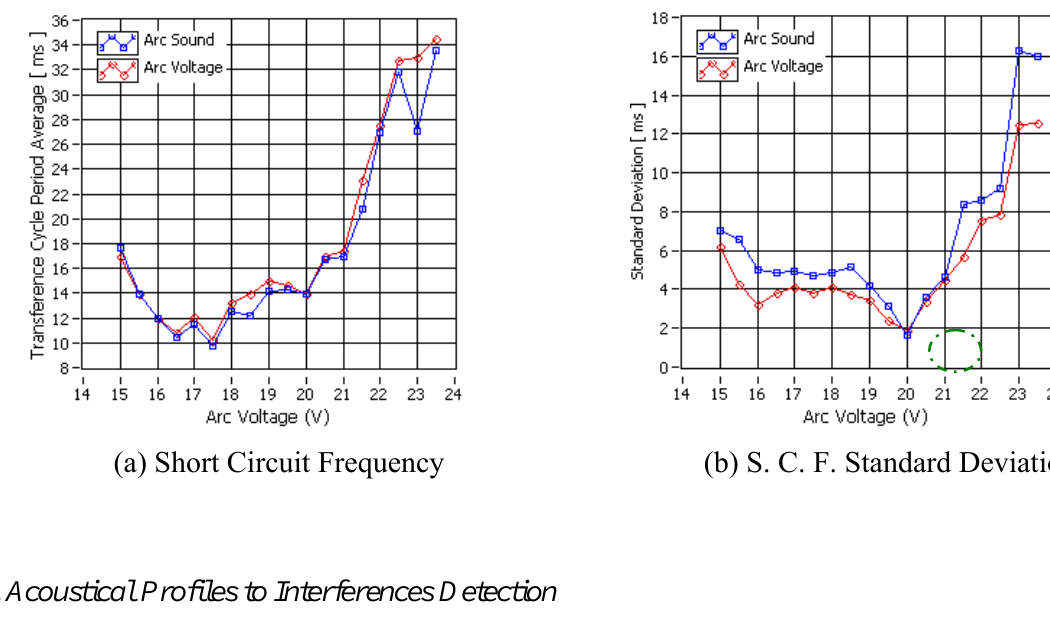
Figure 7. Transference cycle Period vs. Arc